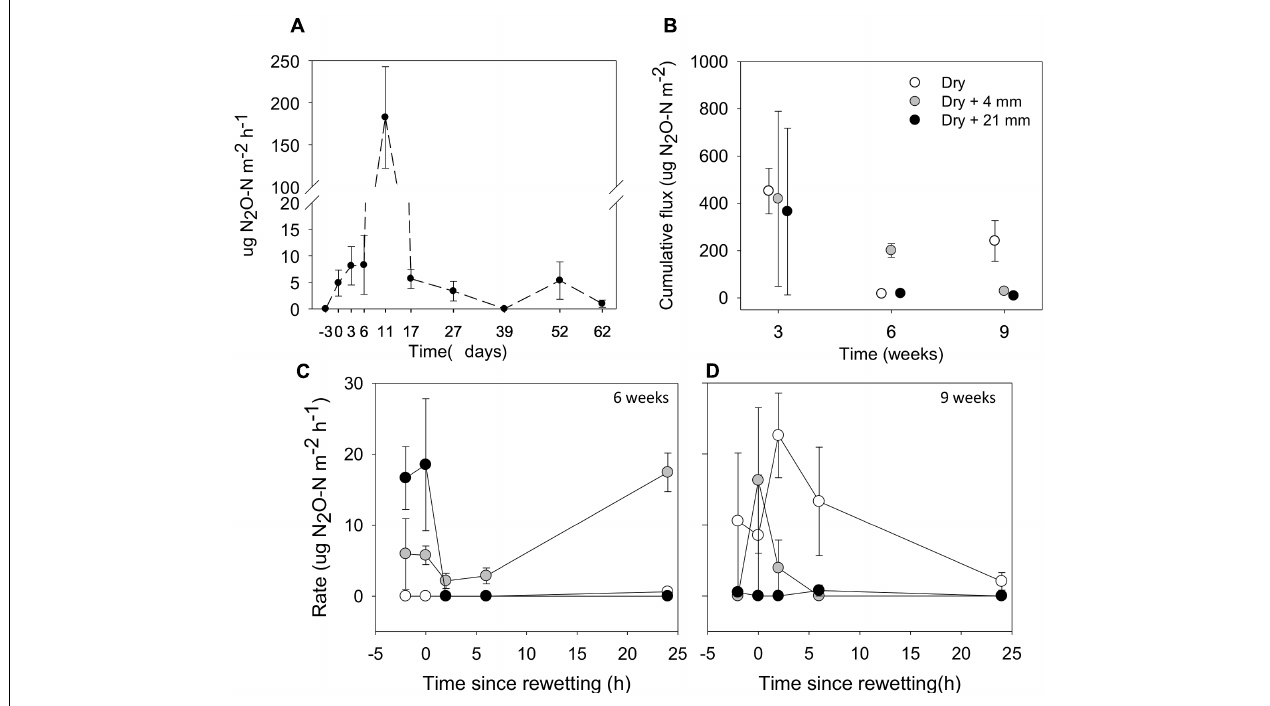
FIGURE 6 | (A) Fluxes of N 2 O from sediments before microcosms drainage (microcosms with a surface water column; t = –3 days), immediately after drainage ( t = 0 days) and several times after drainage and drying. (B) Accumulated fluxes of N 2 O following 24 h under the effects of variable RMs (0, 4, and 21 mm) after the different DPDs. (C) and (D) Fluxes of N 2 O before ( t = –2 h), immediately ( t = 0 h) and following rainfall events ( t = 2, 6, and 24 h) after 6 and 9 weeks of drying, respectively. Values are means ± SE ( n =